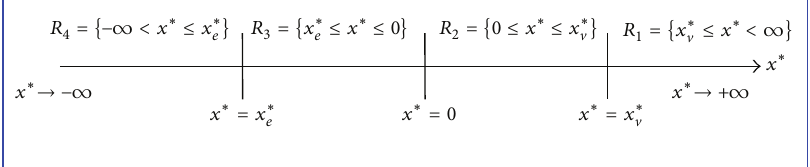
Figure 1: Schematic of the subregions considered for the analysis of a one-dimensional planar premixed spray flame in the presence of volumetric/radiative heat